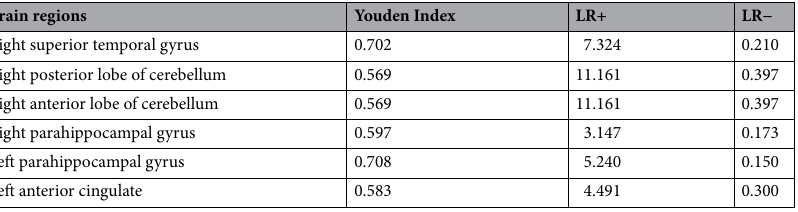
Table 4. ROC analysis of the GMV values in different regions between SA and HC groups. ROC receiver operating characteristic, GMV gray matter volume, SA strabismus with amblyopia, HC healthy control, LR + positive likelihood ratio, LR− negative likelihood ratio.